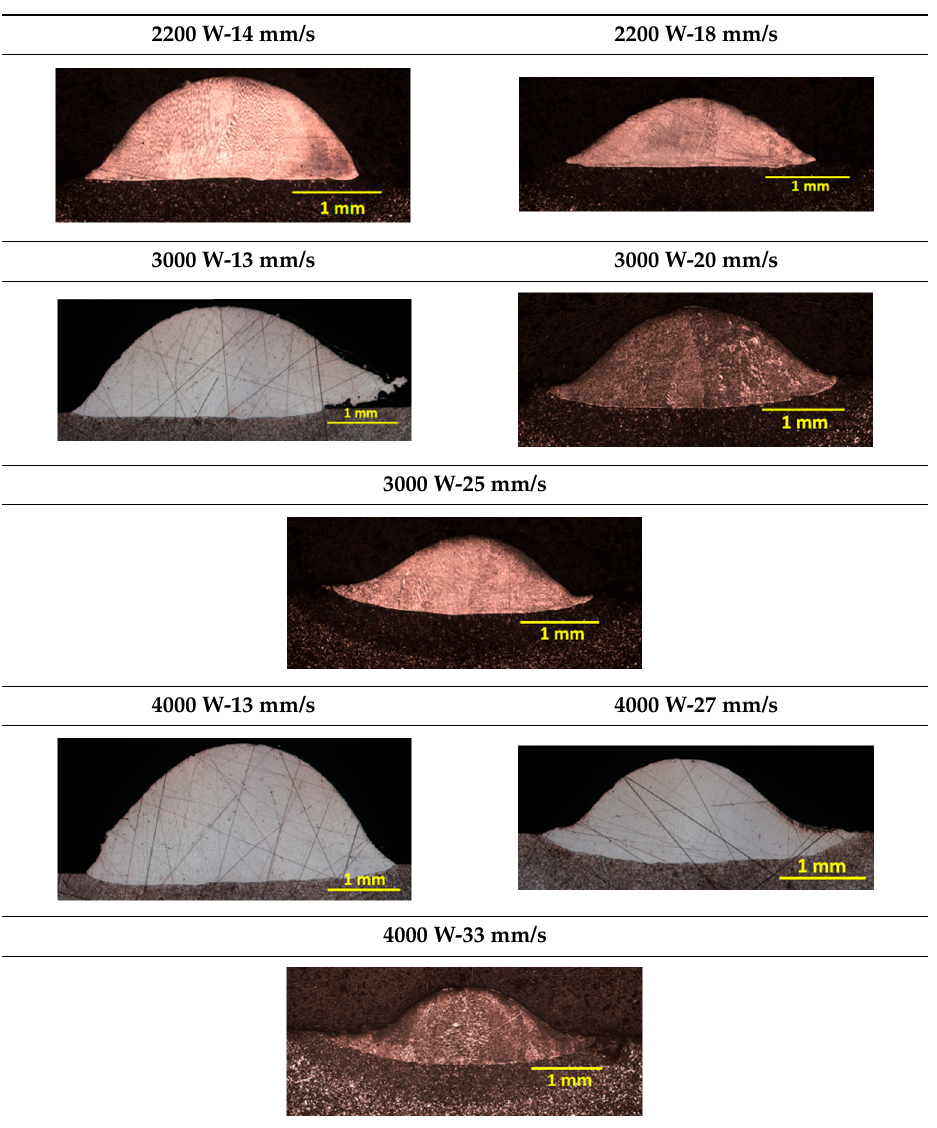
Table 4. Experiments with powder flow of 25 g/min.